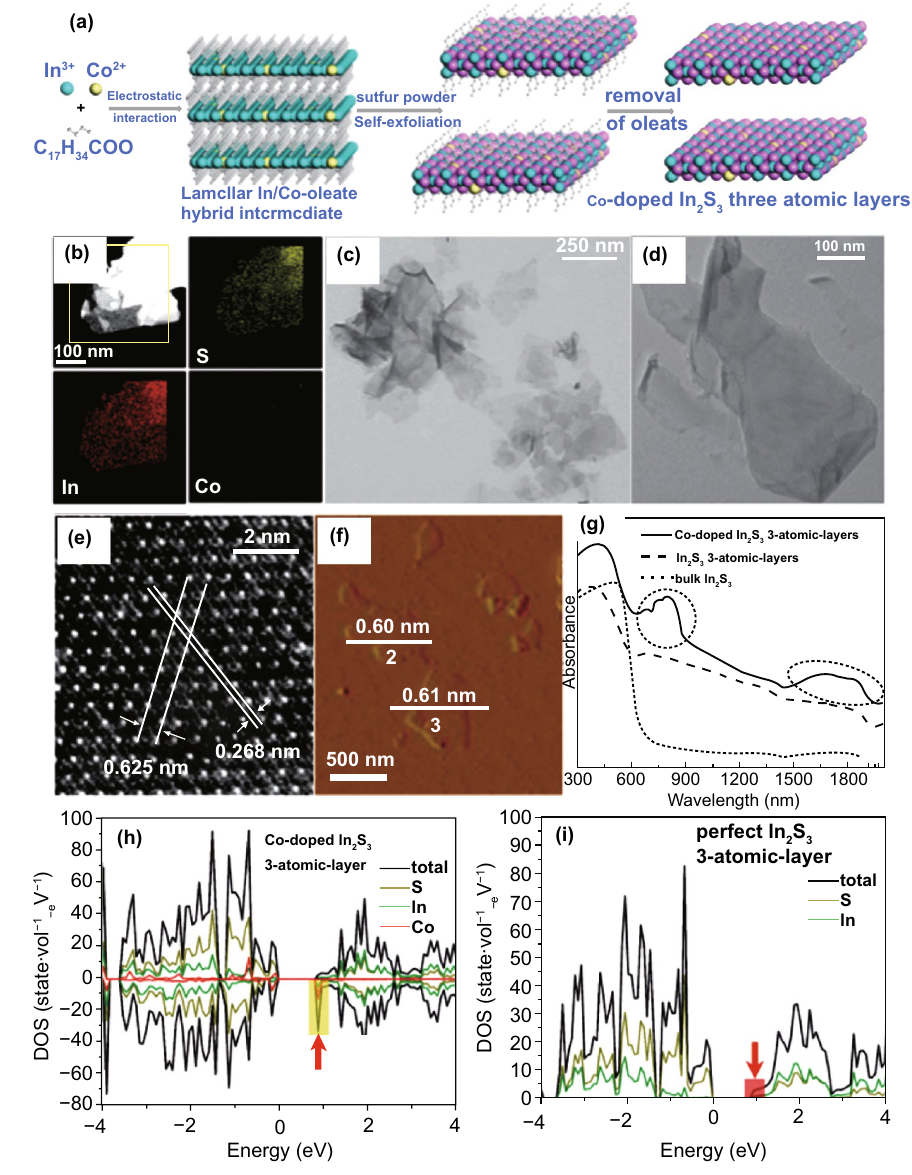
Fig. 10 a Representation of the formation of Co‑doped In 2 S 3 three atomic layers. b–g Characterizations for Co‑doped In 2 S 3 three atomic layers: b HAADF‑STEM image and EDS mapping of an individual Co‑doped In 2 S 3 three atomic layer, c–e TEM images and HR‑TEM image, f , g AFM image, and height profiles. h DOSs of Co‑doped In 2 S 3 three atomic layer slabs and i ideal In 2 S 3 three atomic level slab. Adapted with permission from Ref.